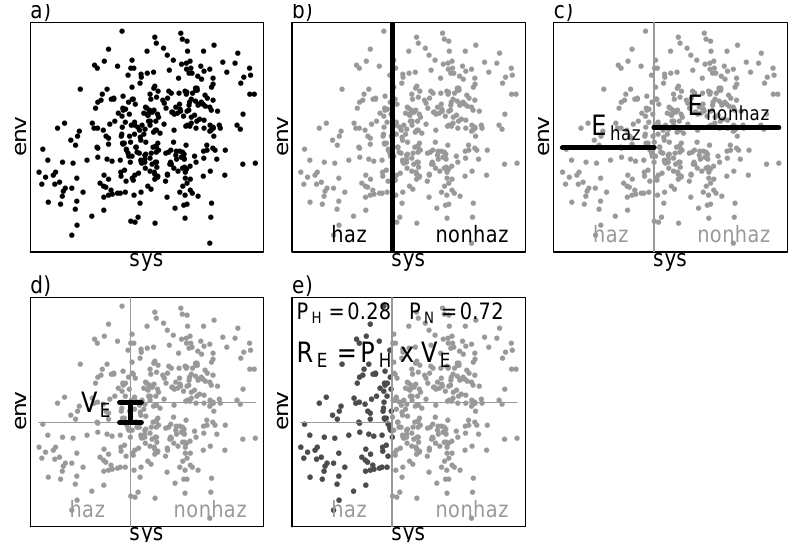
Fig. 1. Schematic representation of ecosystem vulnerability and risk determination. a) regarding sys as independent and env as dependent variable, b) dividing the data set according to the defined hazard for sys into hazardous and non-hazardous subsets, c) calculating expectation values E haz and E nonhaz of env for the two data subsets, d) determining V E as the difference of the expectation values (Eq. 1), e) determining R E as the product of V E and the probability of the hazard occurrence P H (Eq. 3). Intheecosystemvulnerabilityapproach,highvaluesof V E and R E denote high vulnerability and risk towards the re-